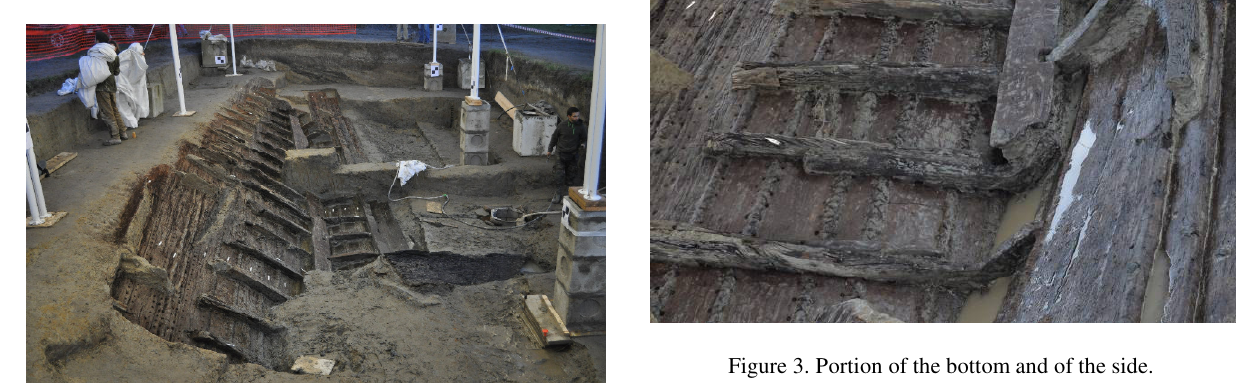
Figure 3. Portion of the bottom and of the